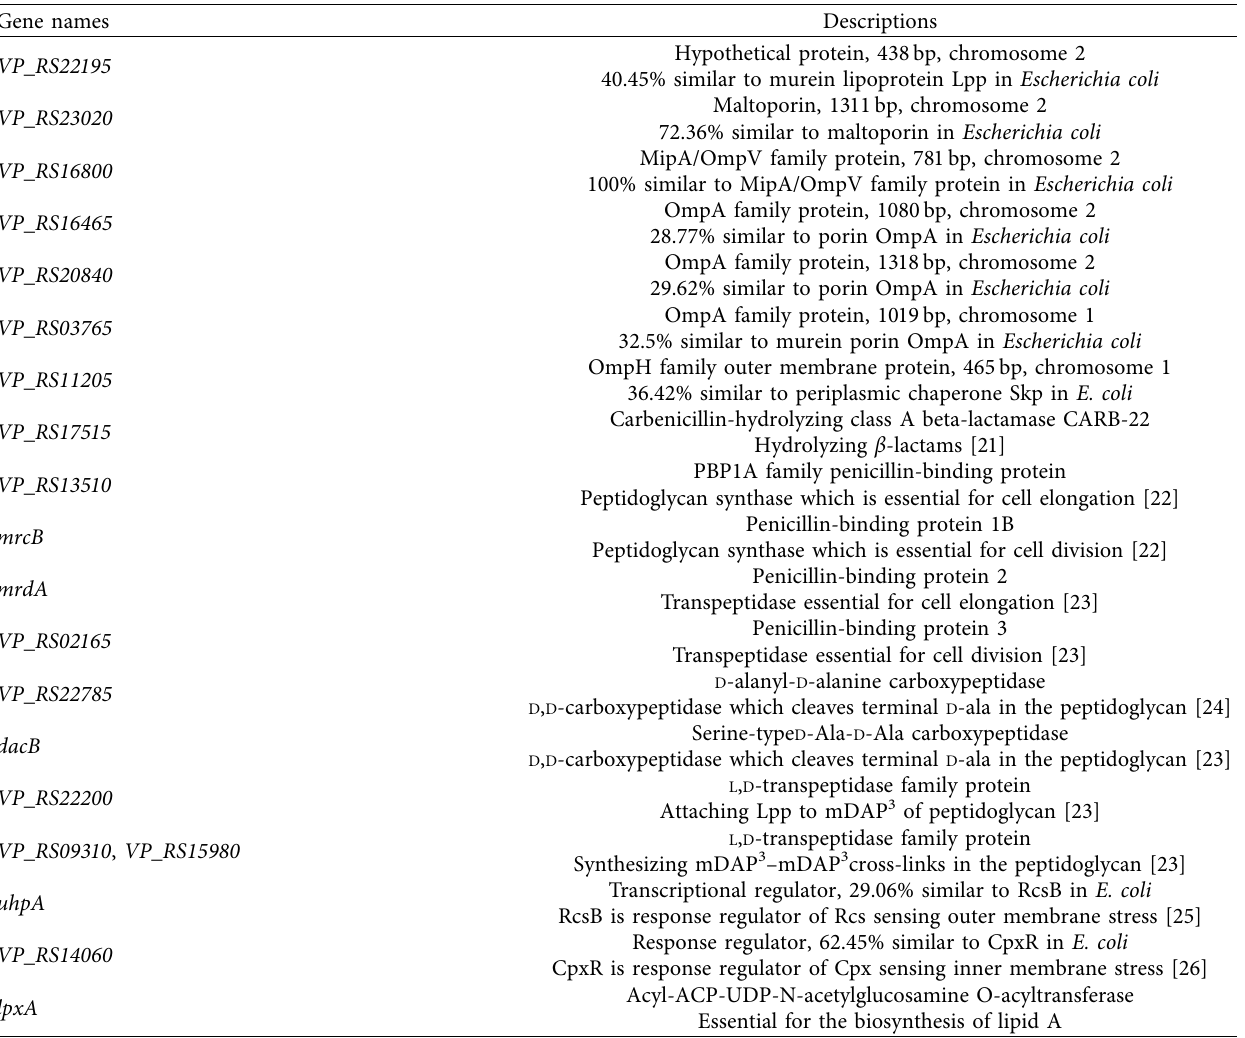
Table 3: Introduction of genes related to this